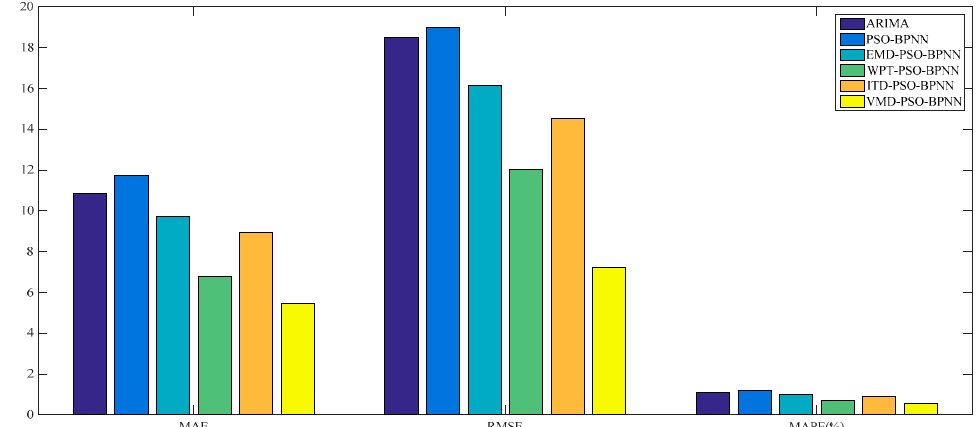
Figure 24. Error graphics of different models of soybean.